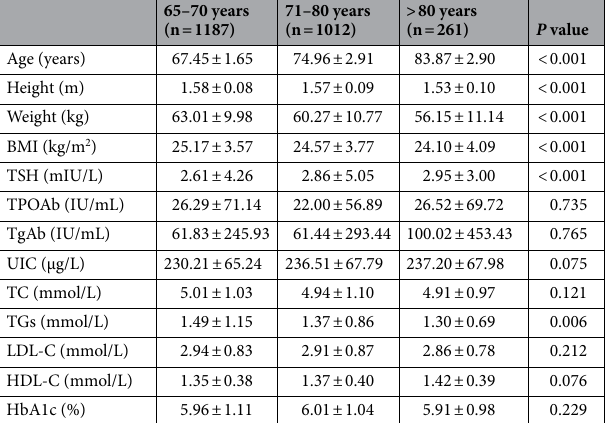
Table 1. Population characteristics of 2460 elderly people. BMI, body mass index; TSH, thyroid stimulating hormone; TPOAb, thyroid peroxidase; TgAb, thyroglobulin antibody; UIC, urine iodine concentration; TC, total cholesterol; TGs, triglycerides; LDL-C, low density lipoprotein cholesterol; HDL-C, high density lipoprotein cholesterol; HbA1c, glycosylated